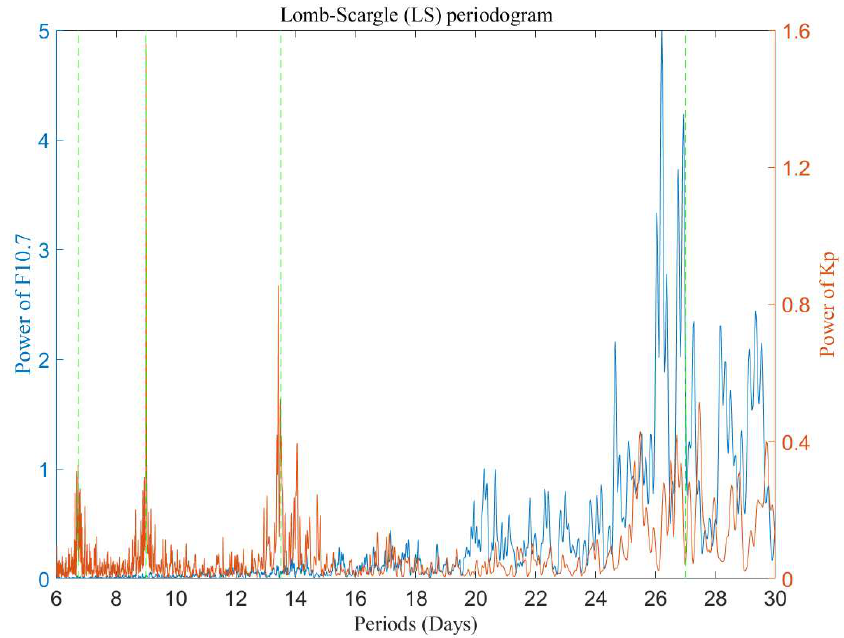
Figure 2. The Lomb-Scargle (LS) periodogram of the original F10.7 (Kp) index. The blue curve represents the periodogram of F10.7 and the red curve represents the periodogram of Kp. The green vertical dash lines represent the four harmonic periods of solar rotation.